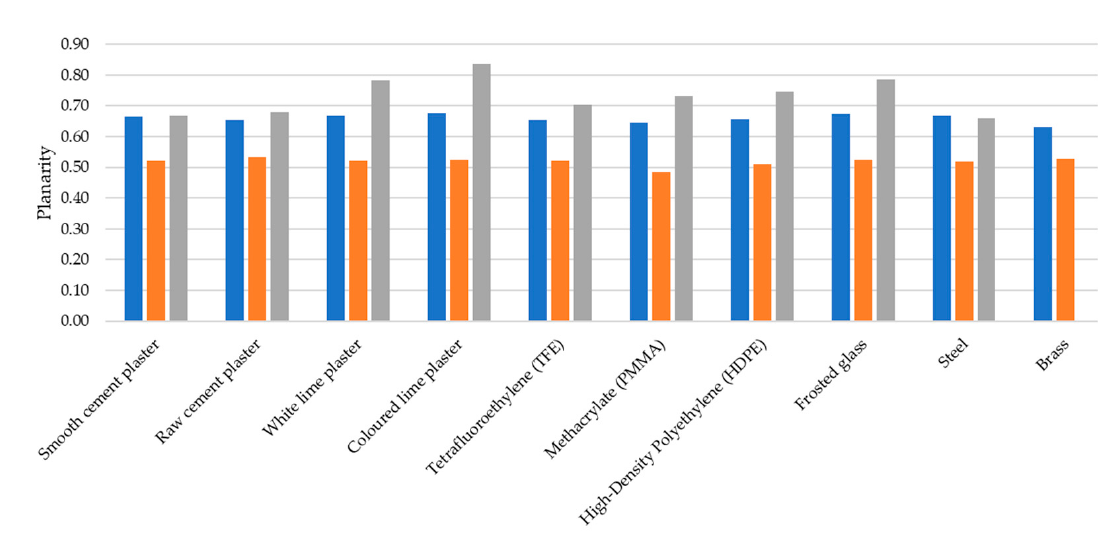
Figure A3. Comparison of mean values of planarity for samples scanned at a distance of 1.5 m.